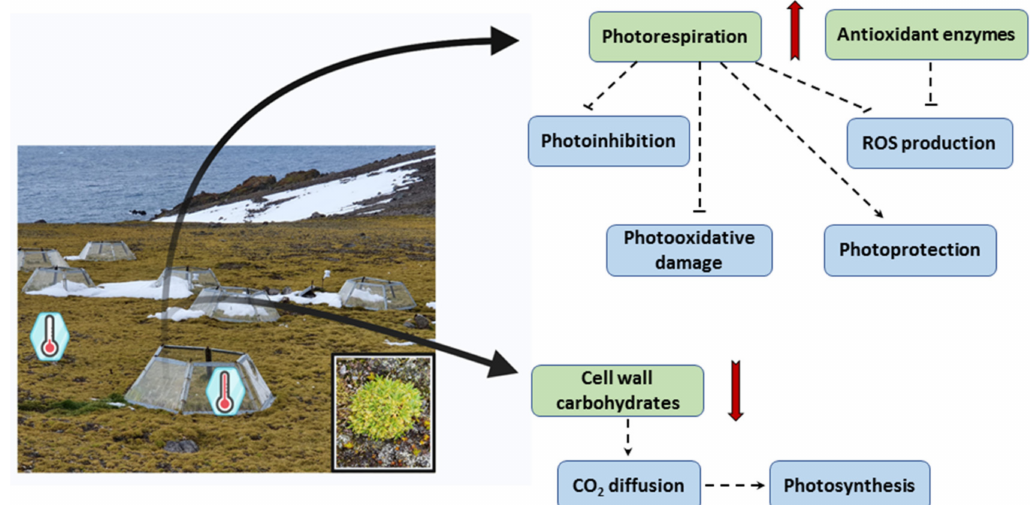
Figure 7. Outline of the main results obtained in the present paper. Continuous red arrows: obtained results; dashed black arrows: inferred information. The figure was created with BioRender.com, accessed on 20 April 2021. Supplementary Materials: The following are available online at https://www.mdpi.com/article/10 .3390/biom11081094/s1, Figure S1: Melting curves of psbA (PSII protein D1) and vde (violaxanthin de-epoxidase) genes, Figure S2: The protein–protein interaction network of differentially expressed proteins (DEPs) in OTC vs. OUT C. quitensis leaf samples, Table S1: List of primers used in the study and related information, Table S2: Complete protein table obtained by MaxQuant using the in-house built C. quitensis protein database, Table S3: Complete protein table obtained by MaxQuant using